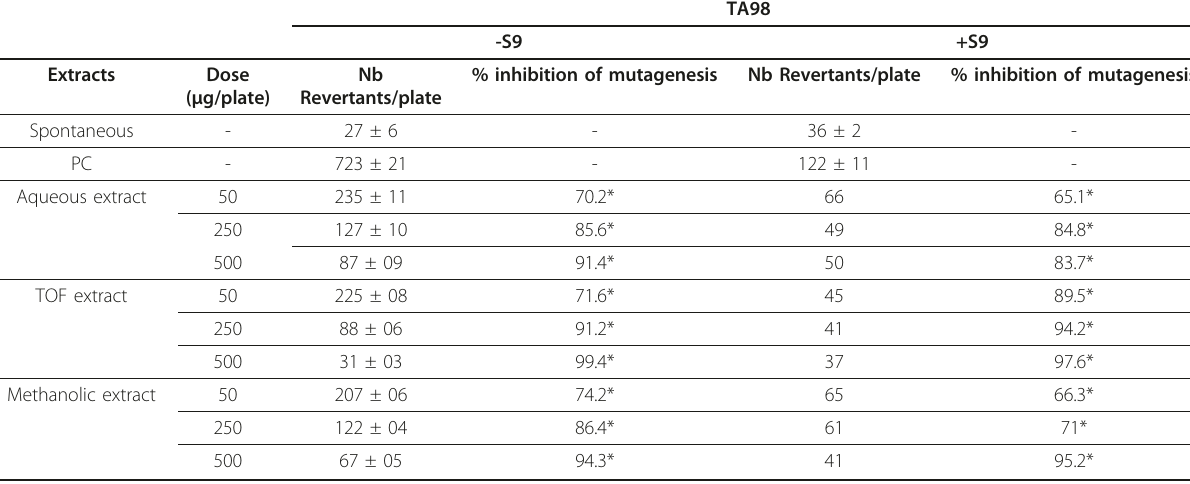
compounds, to be present in the TOF-enriched, metha- by, respectively, 32.6%, 44.6% and 32.6% at the lowest nolic and aqueous extracts, involved in the antimutagenic tested dose (5 μ g/plate). The result of antimutagenic activ- activity of A. salicina extracts and in preventing oxidative lesions [25]. In this study, we used S. typhimurium TA102 strain, which is generally selected for specific The inhibitory effects of A. salicina leaf extracts on the detection of the oxidative damages [26]. Thus we suppose mutagenicity of both direct mutagens (NOPD, MMS) that the constituents A. salicina extracts should inhibit and metabolically activated mutagens (B(a)P, 2-AA), may free radicals and ROS, produced by oxidation and redox- be ascribed to flavonoid and tannin contents of TOF, cycling of both B(a)P and 2- AA, and through reducing methanolic and aqueous extracts [12]. We cannot, how- the activity of enzymes involved in B(a)P and 2-AA meta- ever, exclude the possibility of other compounds, with bolisation. The extracts may both inhibit microsomal antimutagenic properties, participating to the antimuta- activation and directly protect DNA from the electrophi- genic effect of A. salicina extracts. The results of our experiments are consistent with the known antioxidant activities of flavonoids [23] and tannins [24]. Flavonoids metabolite [27]. They may also protect DNA from the are the most likely candidates, among the known Table 4 Mutagenic activity of extracts from A. salicina by the S. typhimurium TA98 and TA102 assay systems in the presence and absence of the metabolic activation system (S9) Extracts Spontaneous Aqueous extract